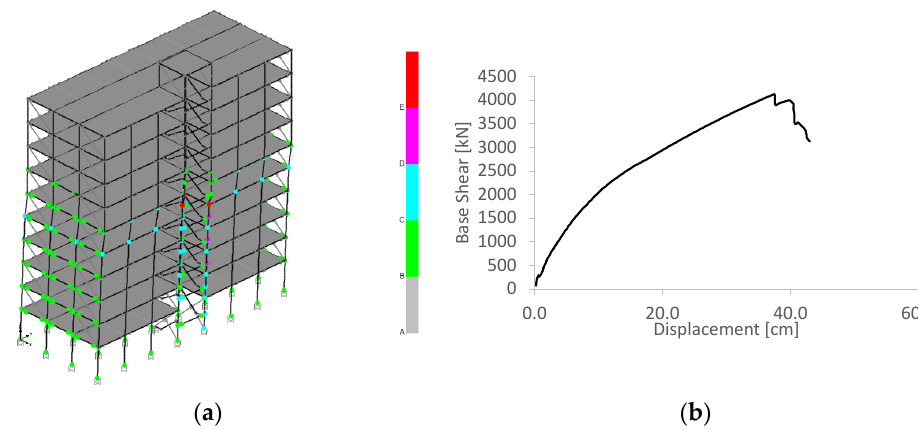
Figure 6. Pushover analysis, ( a ) deformed shape and ( b ) capacity curve in x directions.